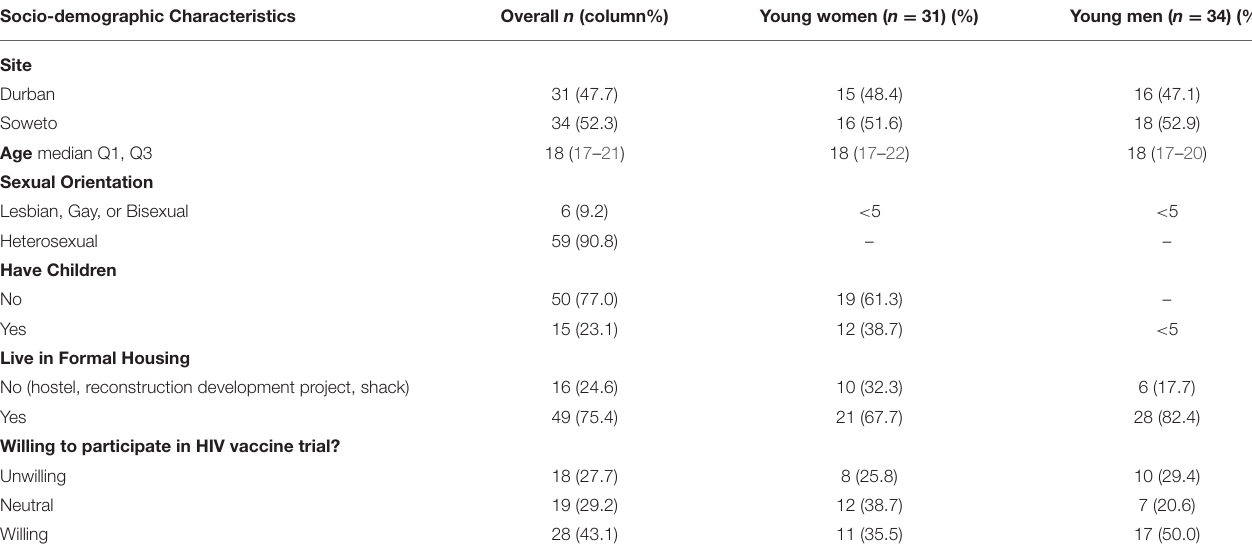
TABLE 2 | Characteristics of AYAZAZI participants in focus group discussions (FGDs), overall and by gender ( n = 65). Socio-demographic